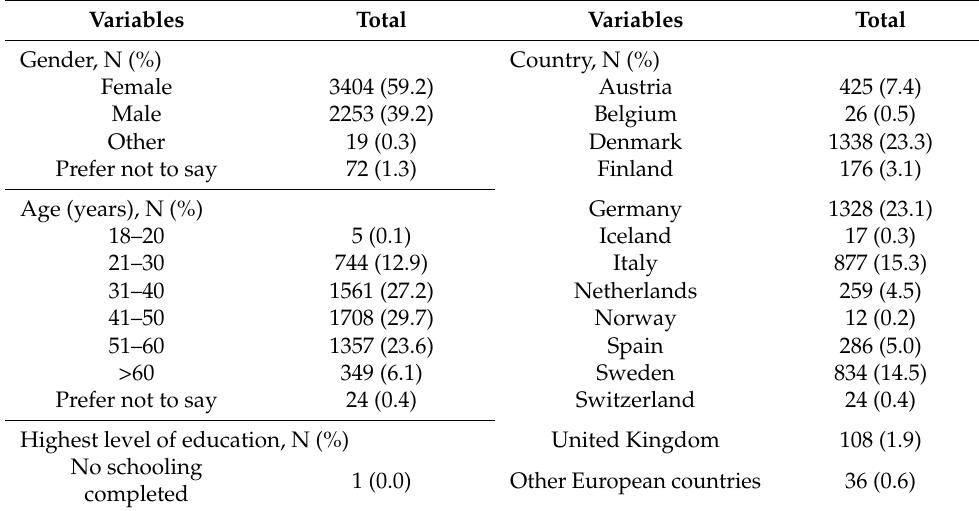
Table 1. Characteristics of the